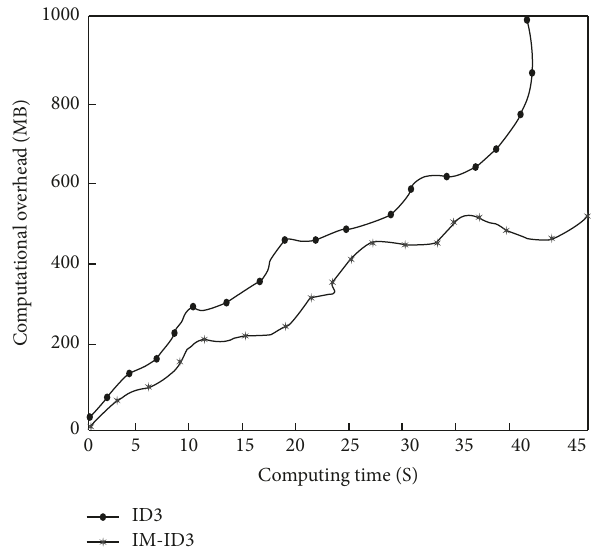
Figure 4: Results of interactive virtual reality (VR) genetic algo- rithm in optimizing the construction effectiveness of higher vo- cational business English